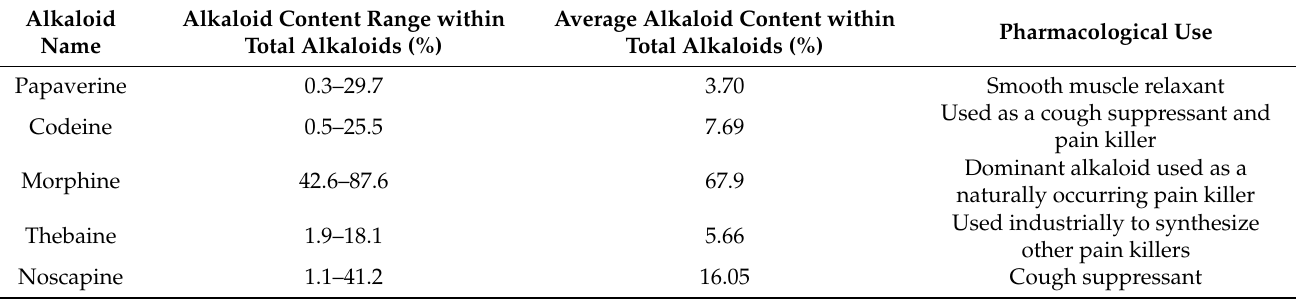
Figure 1. Chemical structure of PPV (Image designed by DA Gomes using ChemSpider (released in 2008, Royal Society of Chemistry, Raleigh, North Carolina, United States of America) . Table 1. A breakdown of the main alkaloid contents extracted from Papaverine somniferum [8,10] .